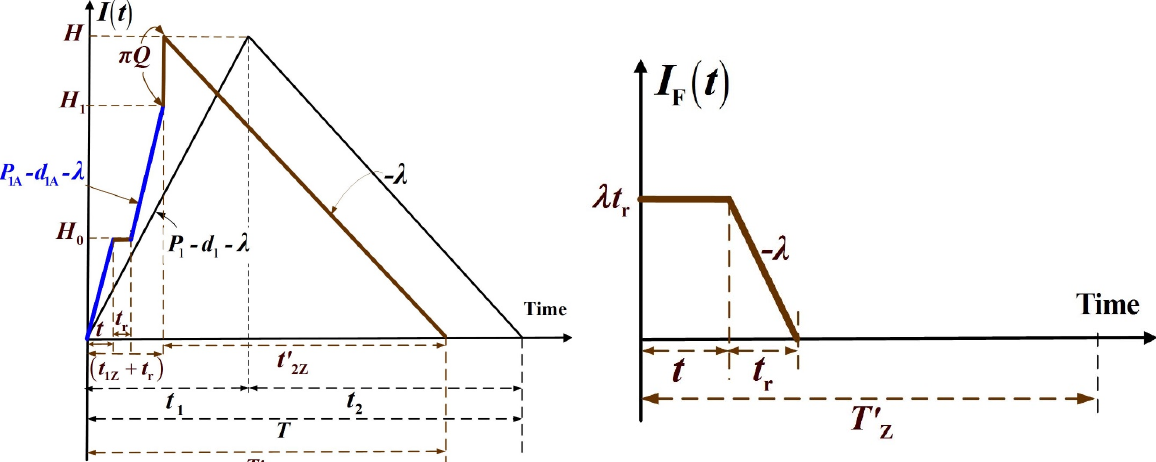
Fig. 2. The safety product level in condition one